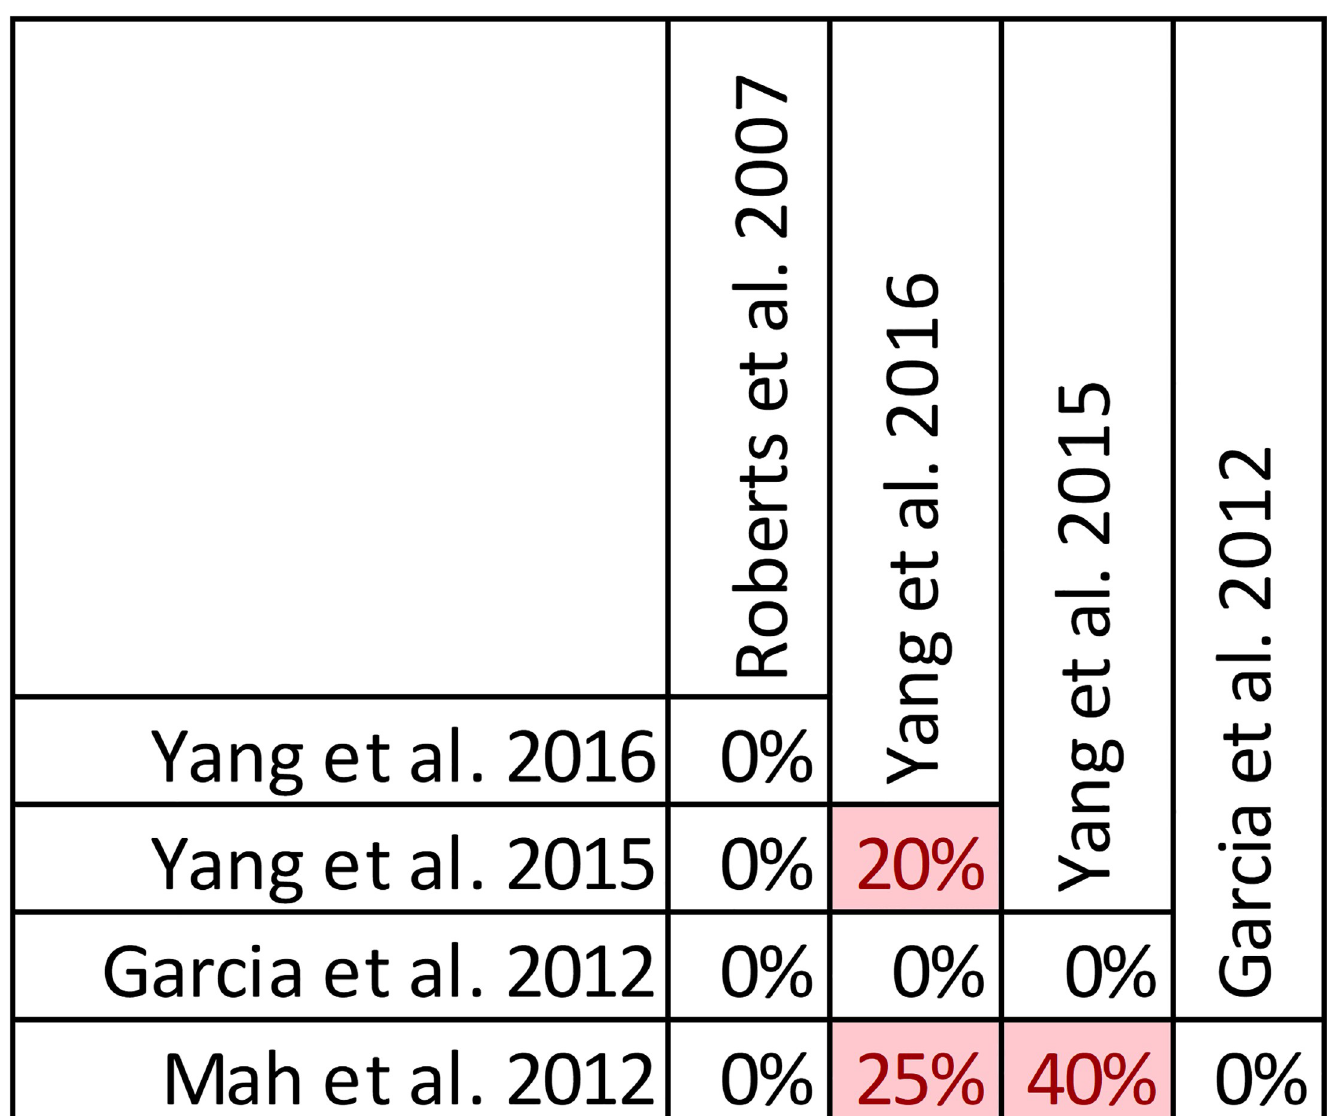
Fig 17. Pairwise CCA for reviews reporting cost of prolonged versus intermittent infusions of beta-lactams. Colors indicate degree of overlap, as calculated with CCA, for visual clarity. White = � 5%, green 5.1–9.9%, yellow 10–14.9%, red � 15%. N/A indicated where primary studies included were not reported by systematic